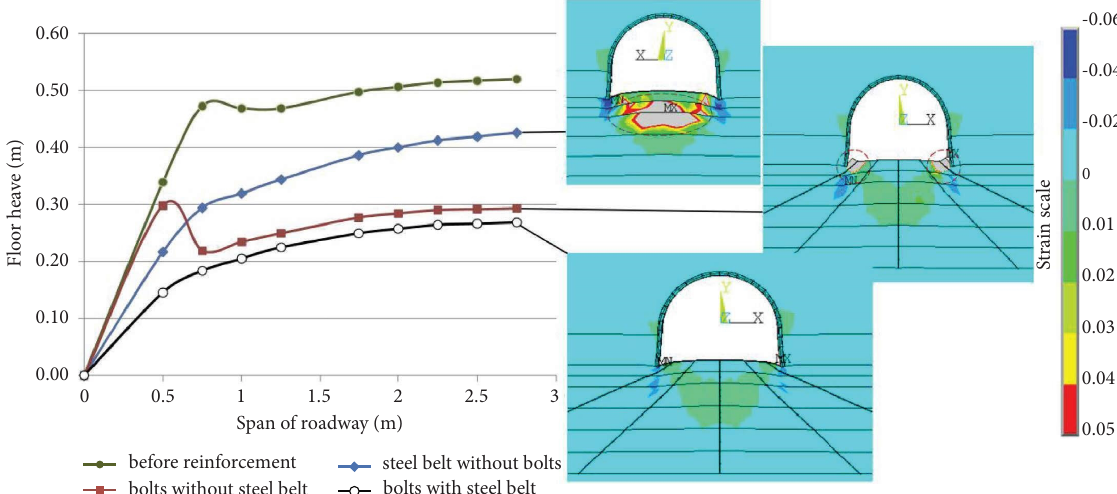
Figure 18: Floor heave on monitoring line B-B 1 and vertical plastic strain distribution around the roadway before and after reinforcement with diferent support elements (foor support scheme